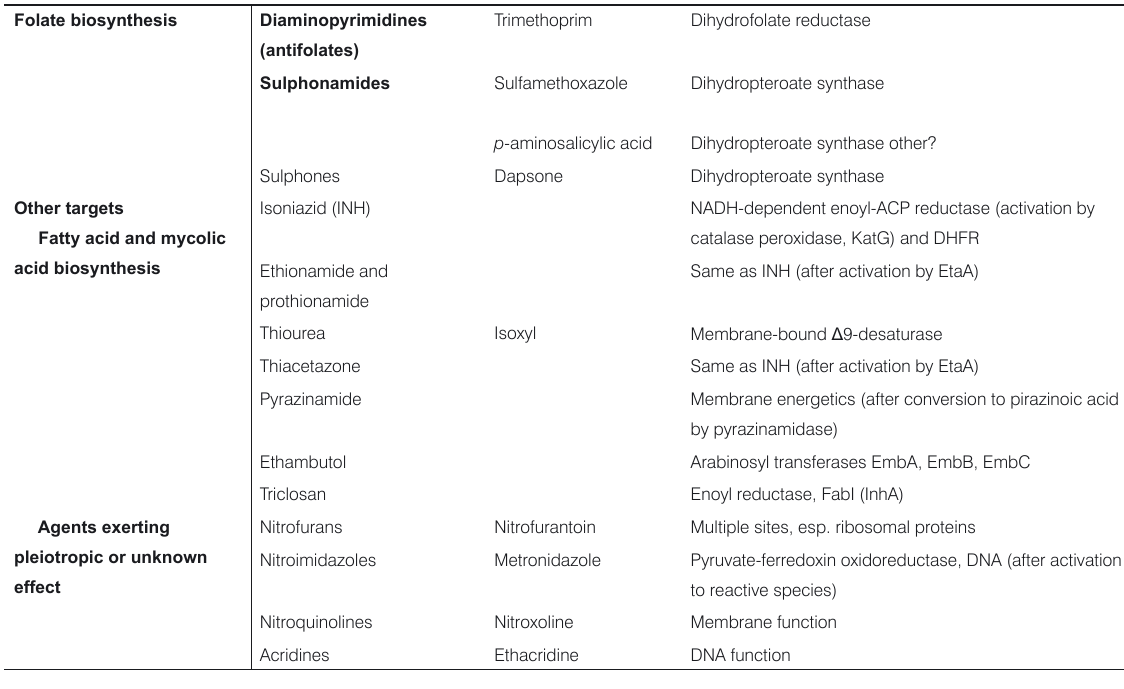
Table 2. Resistance mechanisms to the main antibacterial